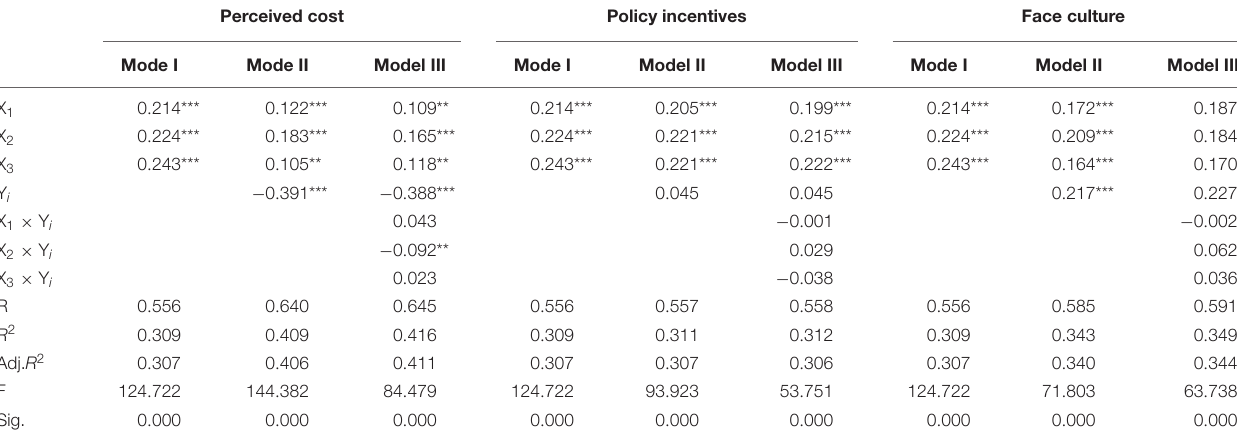
TABLE 4 | Test results of the moderating effects of perceived cost, policy incentives, and face culture.